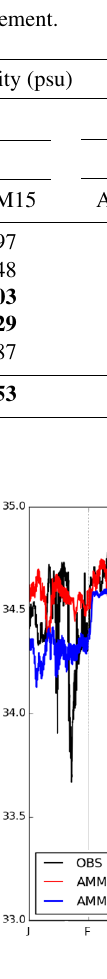
Figure 13. Sea surface salinity at the NsbII mooring for January– September 2017. The black line represents the observations; the red and the blue lines represent AMM15 and AMM7, respectively. Ob- servations are missing for the period of October–December.